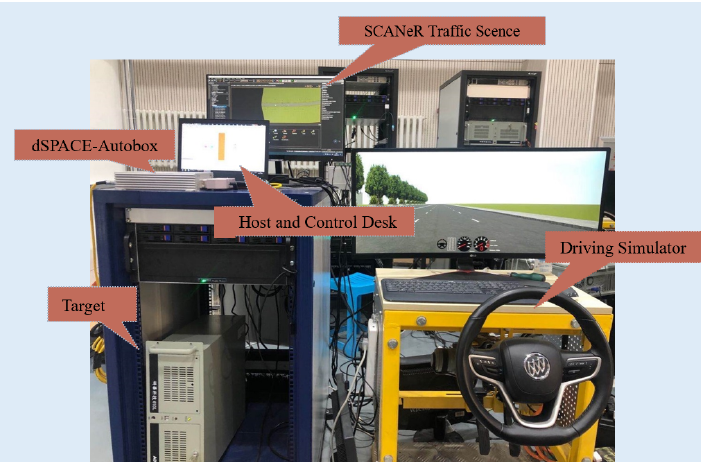
Figure 5. The HIL experimental